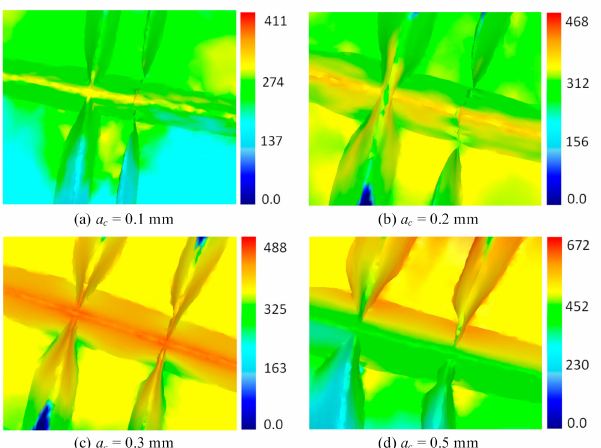
Figure 10. Equivalent stress distribution with di ff erent stamping depths. ( a ) a c = 0.1 mm; ( b ) a c = 0.2 mm;